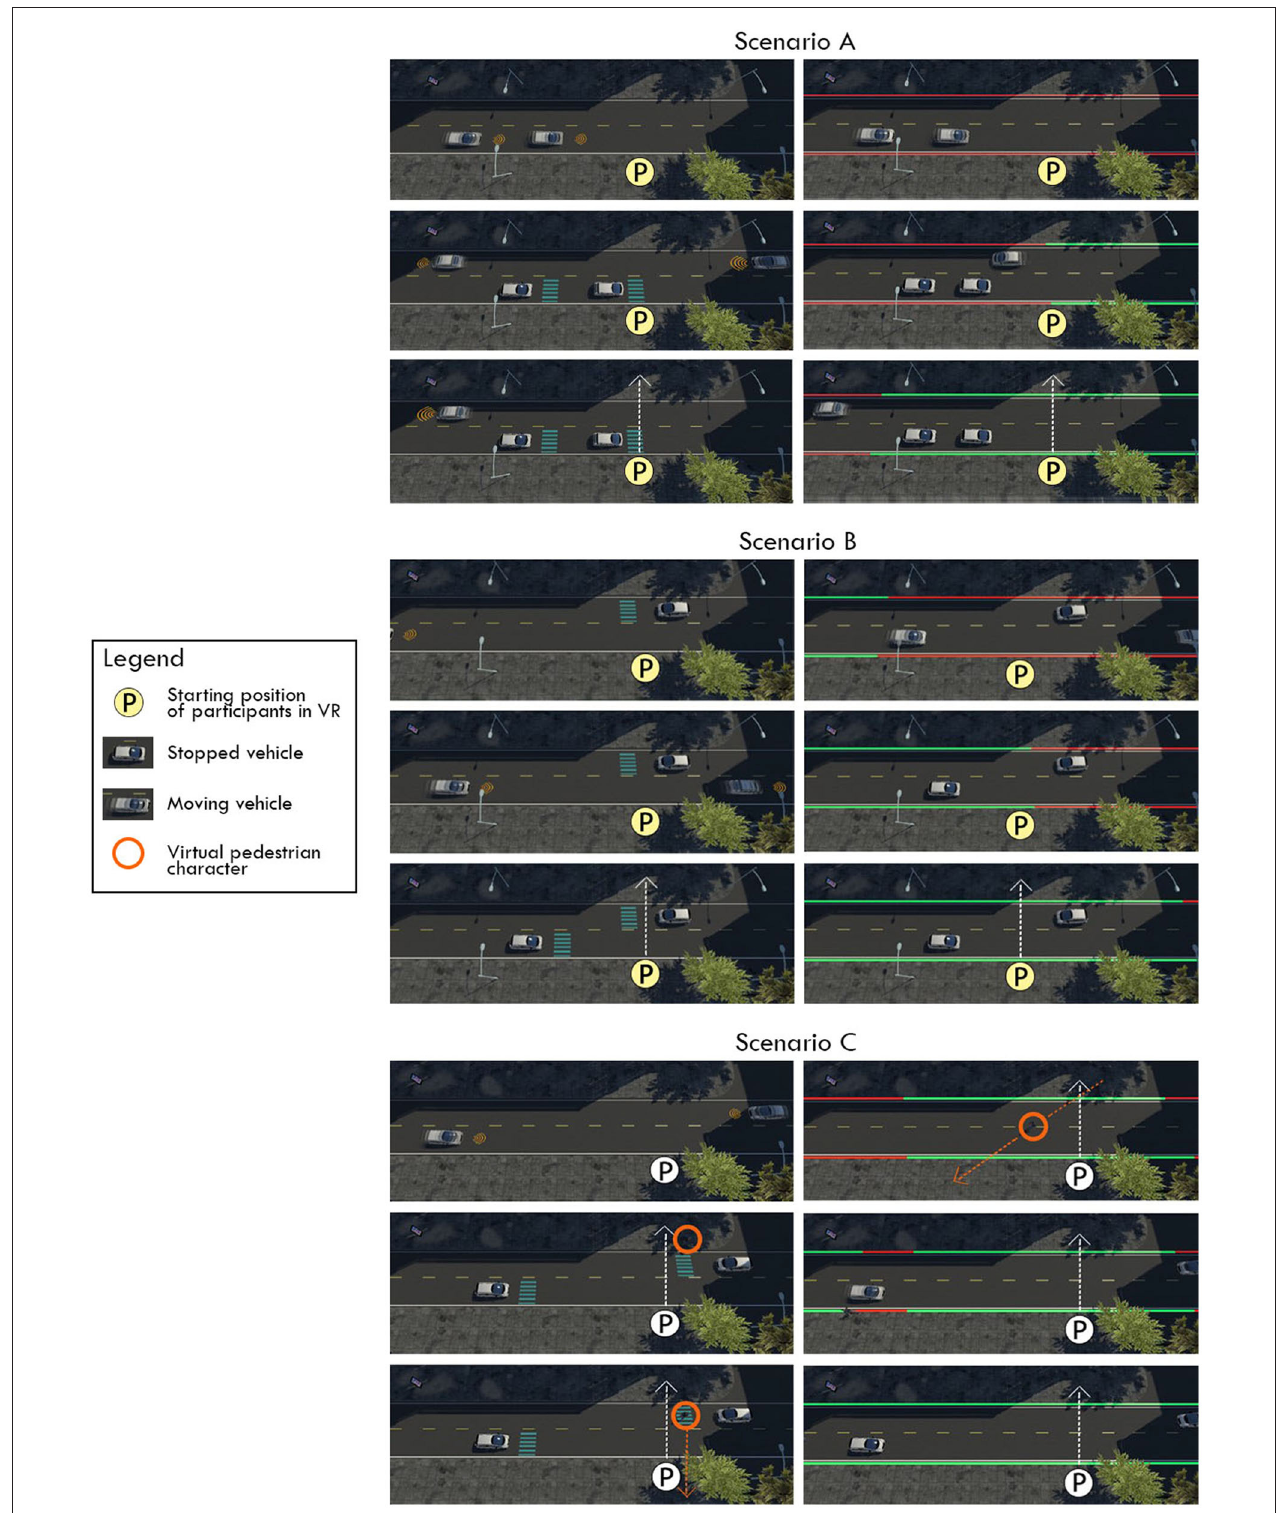
FIGURE 2 | Still images from the three tested scenarios in VR, (left: Projections, right: SmartCurbs). “P” marks the starting position of participants. Vehicles in motion at the given point in time are slightly blurred to indicate this. In Scenario C, the orange circle marks the virtual pedestrian character. This figure includes three blocks of images (each one for a respective Scenario (A, B, and C). The images contain screenshots from the VR scenario which match the descriptions from Section 4.1 (“Scenarios.”).